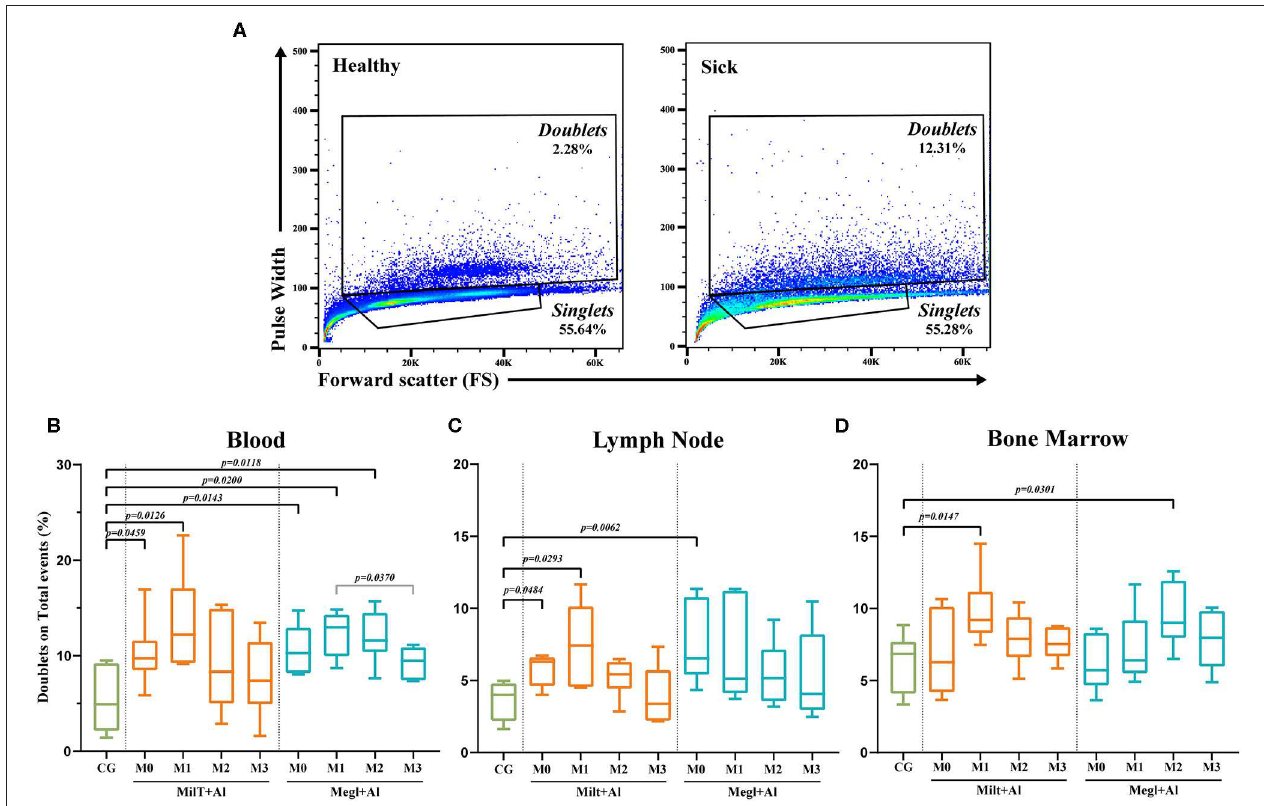
FIGURE 3 | Doublet analysis. (A) Gating strategy example in the blood of a healthy [control group (CG)] and a sick dog (M0). Percentage of doublets gated on total events for blood (B) , lymph node (C) , and bone marrow (D) before and after the beginning of treatment. Results of 22 dogs are represented by box and whisker plots and median, minimum, and maximum values. The non-parametric Kruskal–Wallis test (one-way ANOVA on ranks) with Dunn’s post hoc test was used for statistical comparisons between treatment groups and the control group (CG). The repeated measures ANOVA test with Tukey’s post hoc test was used for statistical comparisons inside each treatment group. p -values are indicated in every statistically significant comparison.